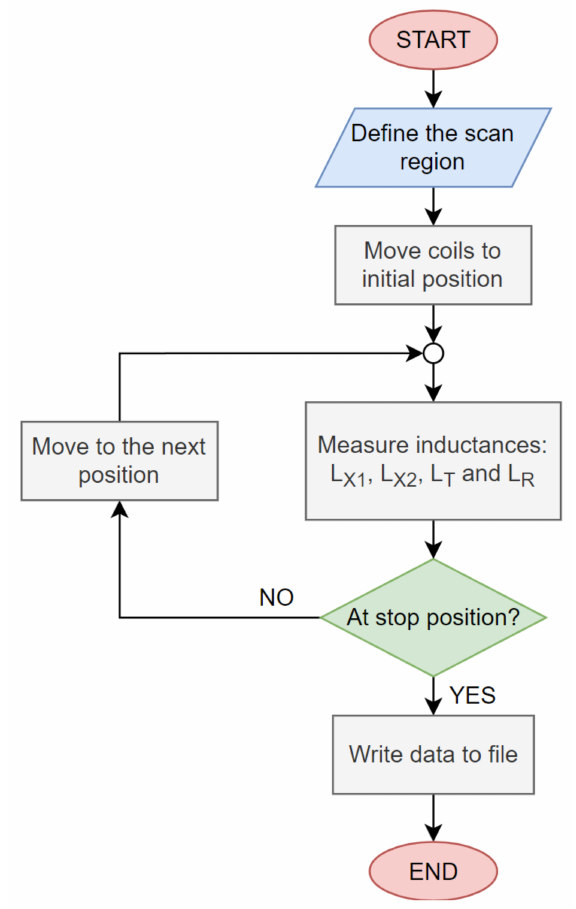
Figure 6. Inductance measurement